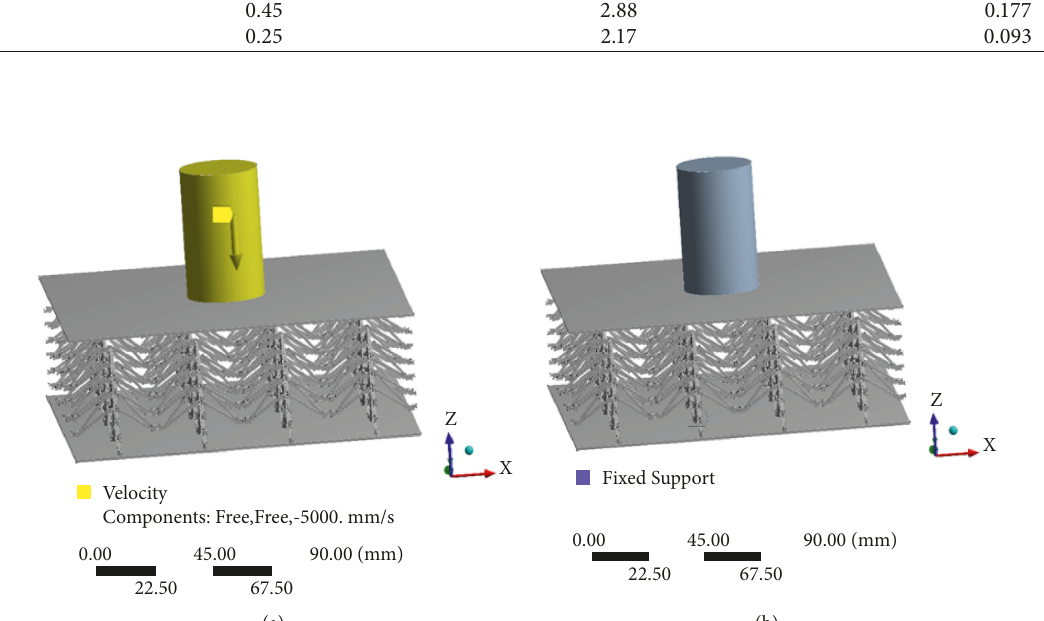
Figure 16: Low-speed impact simulation. (a) Loading and (b) boundary